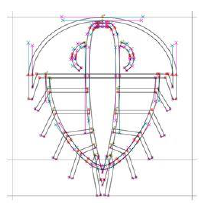
Figure 9 . Visualization of the symbol outline as a polygon.